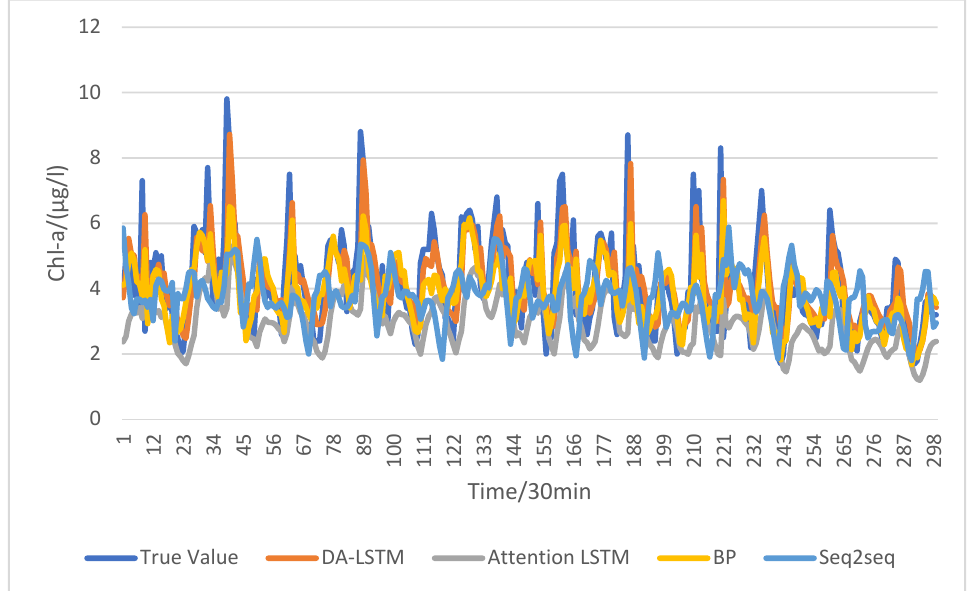
Figure 3. Chl-a prediction using different methods (12 time intervals).